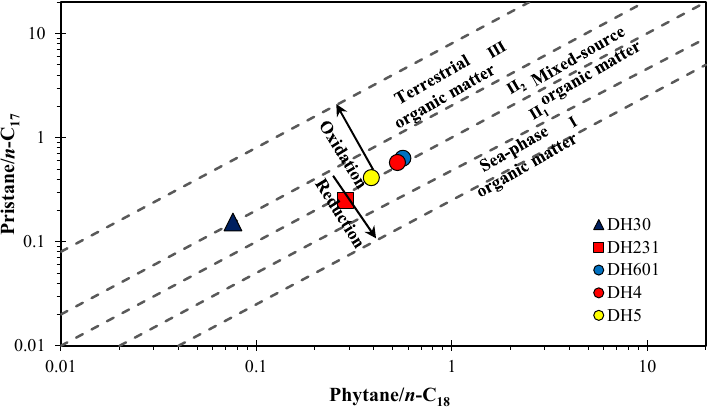
Figure 11. The cross plots of Pr/nC17 and Ph/nC18 of Ordovician crude oil and the wellhead blockage.